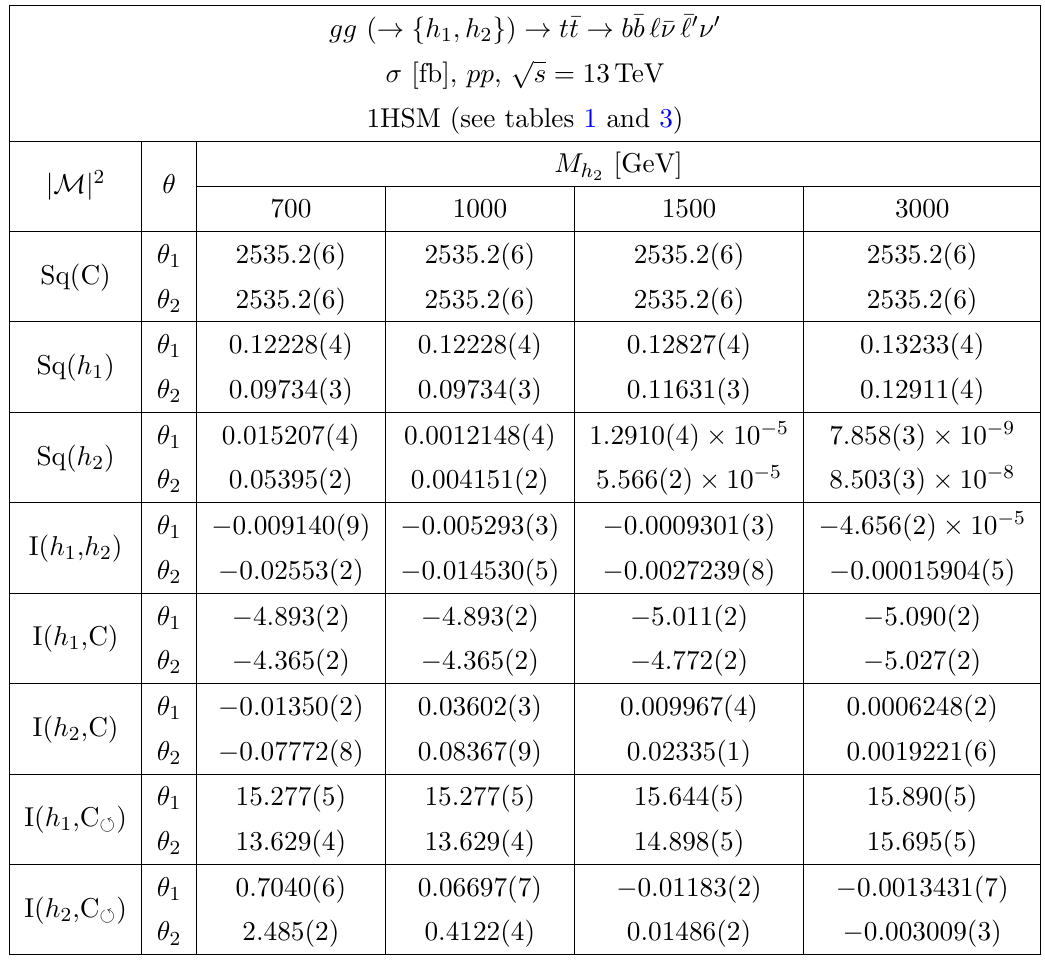
Table 12 . Cross sections for gg ( the 1HSM. Other details as in tables 9 and